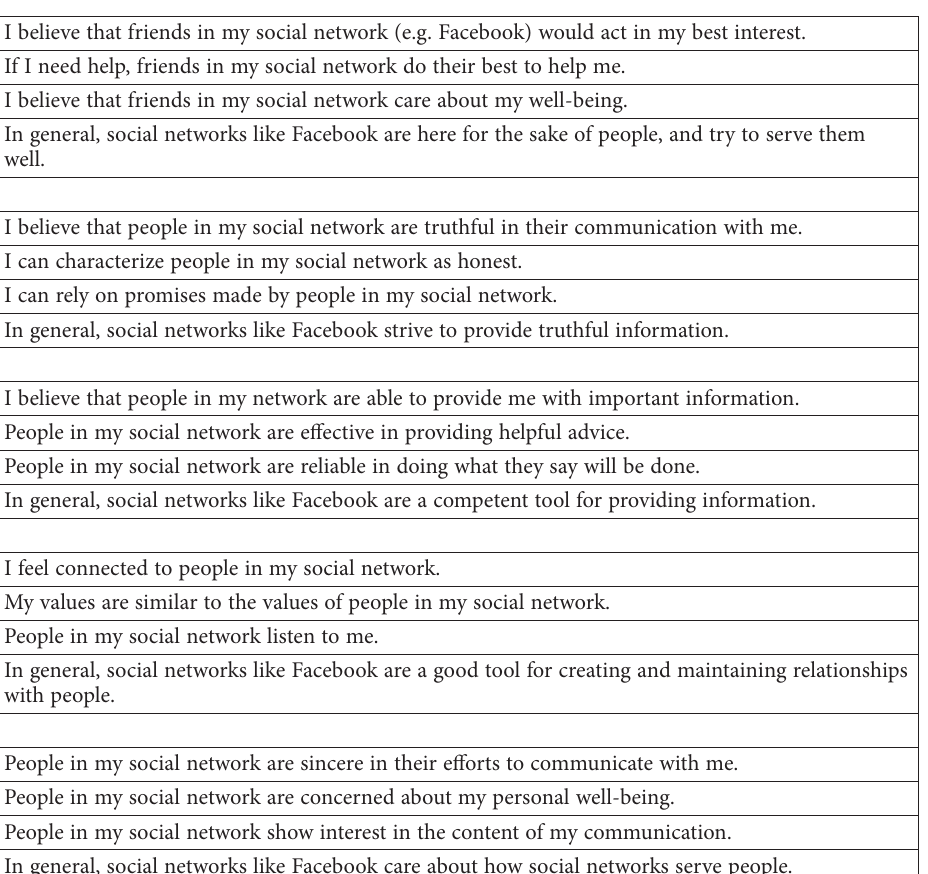
Table 1A. Labels of questions Q12_1 – Q12_20 (source: own